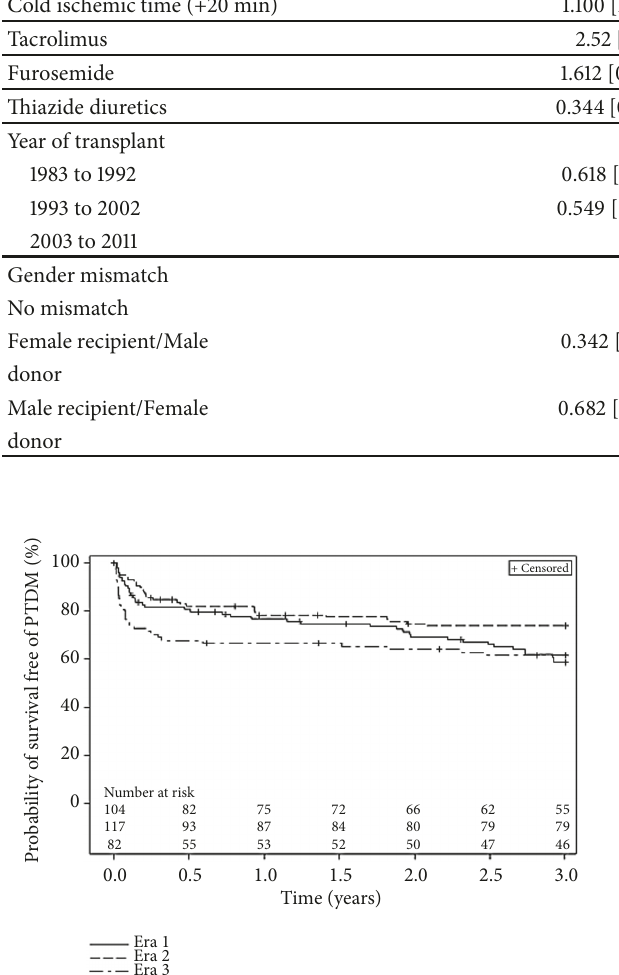
Figure 3: Kaplan Meyer curves for survival free of diabetes accord- ing to the transplant era. Overall p value; 1 year = 0.067; 3 years =